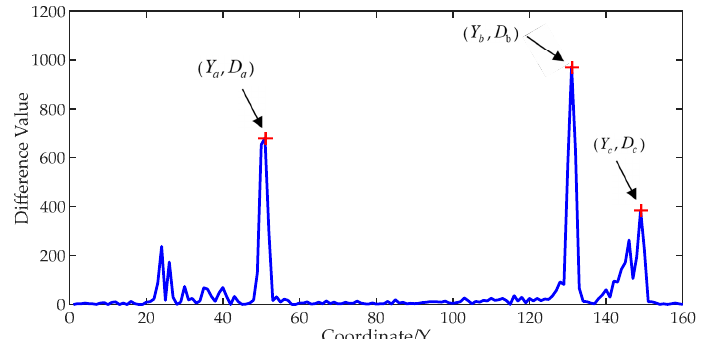
6 of 16 Figure 4. The graph of image accumulated grayscale value. Where Y a is the coordinate position of the air–oil boundary, Y b is the coordinate position of the oil–water boundary, Y c is the coordinate position of the container’s bottom. C a , C b , and C c are the grayscale accumulated values of the corresponding positions. 2.2.3. Finding First Derivative of the Accumulations It can be seen in Figure 4 that the grayscale accumulated value of the upper oil part is lower and the grayscale accumulated value of the water part is higher. The corresponding coordinates of the concave portion in Figure 4 are the positions of oil in the two-dimensional image. The coordinates of each component in the water–oil layered mixture can be obtained by finding the mutations of the grayscale accumulated values. This paper proposed the IGAVD algorithm. According to the sharp changes of the gray value at the edges of the image and gradient operators [20,45] on the basis of one-dimensional gray accumulated value data curve, the accumulated grayscale value of adjacent coordinates is processed by calculating first derivative in turn, and the absolute value of the result is obtained. Difference processing as: